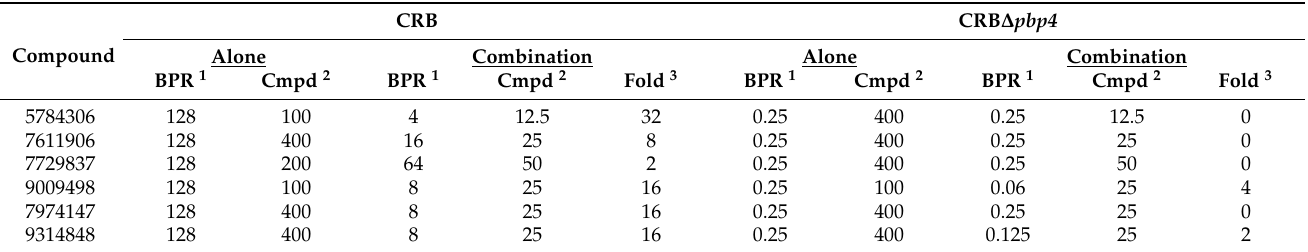
Table 2. Antimicrobial effects of ceftobiprole and putative PBP4 inhibitors. CRB CRB ∆ Compound